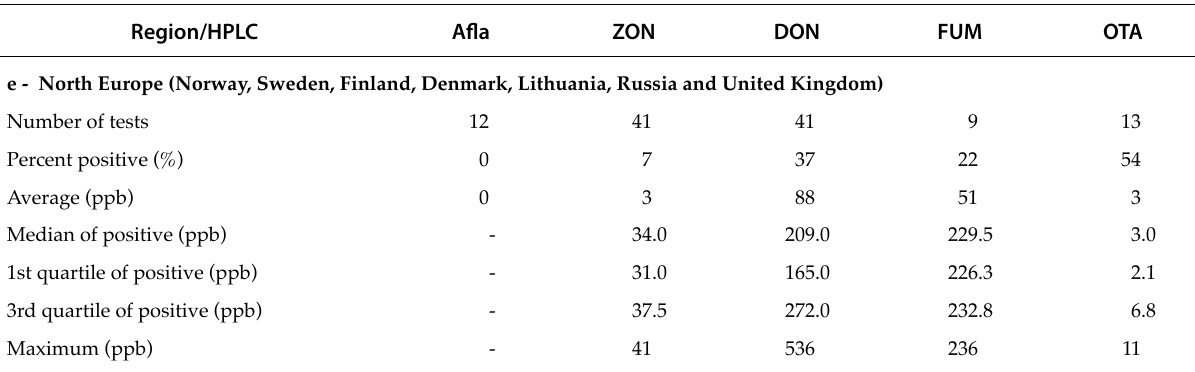
Table 6. Continues